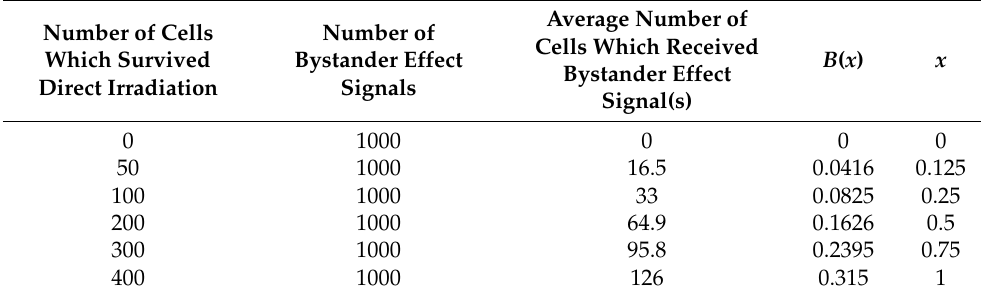
Table 2. The calculated numbers of cells received the bystander effect signals, B ( x ) and x , for the BSDM model. Source of the experimental data: [16]. Average Number of Number of Number of Cells Cells Which Bystander Effect Which Survived Signals Direct Irradiation